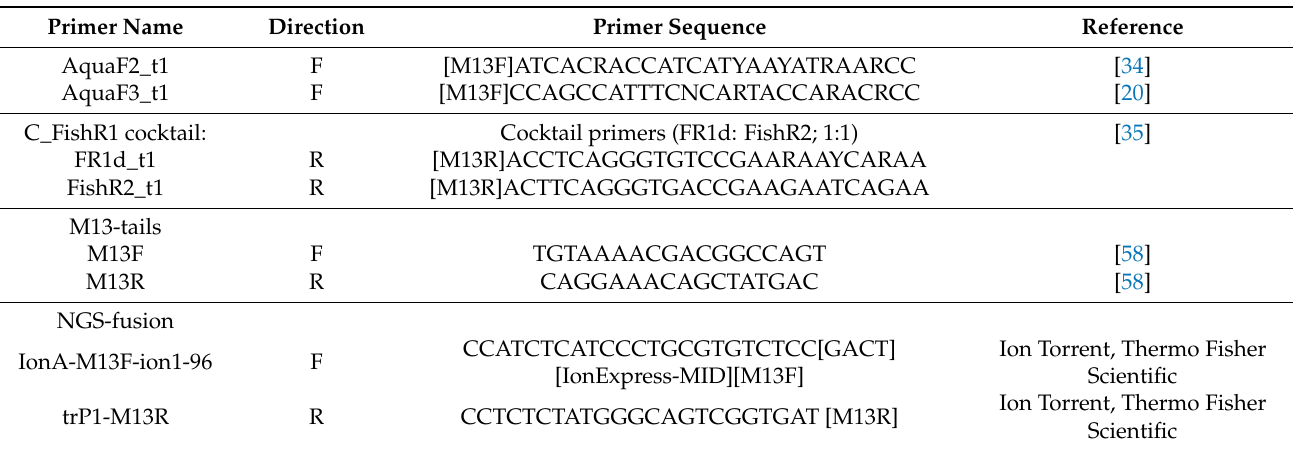
Table 2. Primers used in the eDNA process. All listed primers are 5 (cid:48) to 3 (cid:48) . The explanation is in the